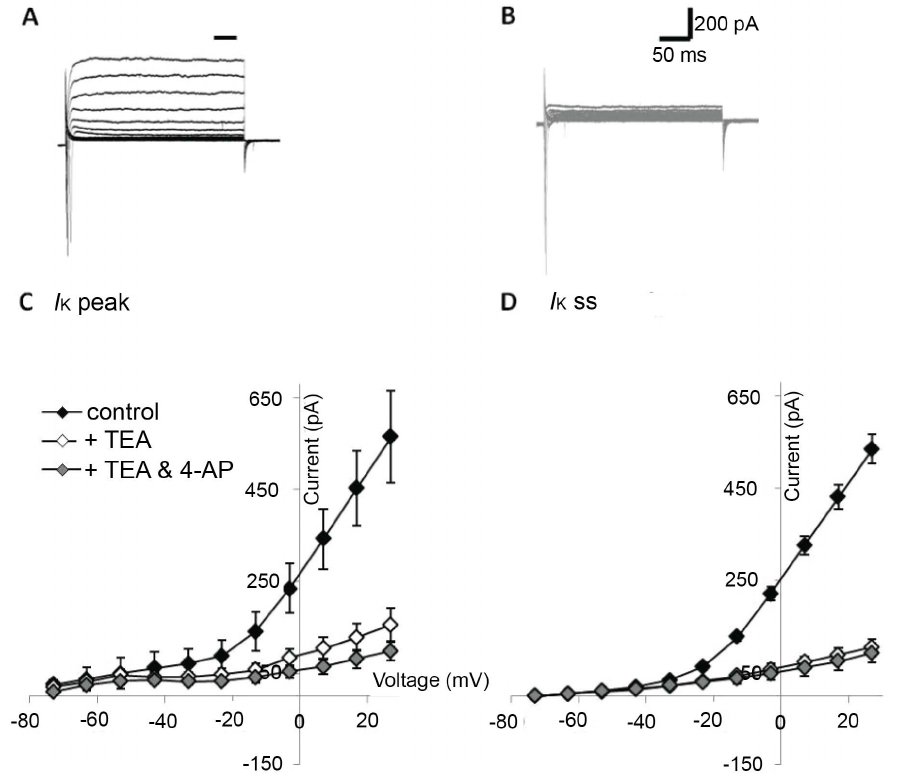
Figure 2. Outward currents recorded from FA iPS-derived neurons. ( A ) Membrane depolarization activates a transient sodium current followed by a sustained outward current that is attenuated by potassium channel blockers TEA (10 mM) and 4-AP (1 mM) ( B ). C–D. I–V curves depicting peak outward potassium current ( C ; I K peak) and steady-state current ( D ; I K ss, measured at bar in A ) as a function of membrane potential. Currents recorded in the absence of all channel blockers (closed) were reduced in the presence of TEA (open), or TEA and 4-AP (gray).